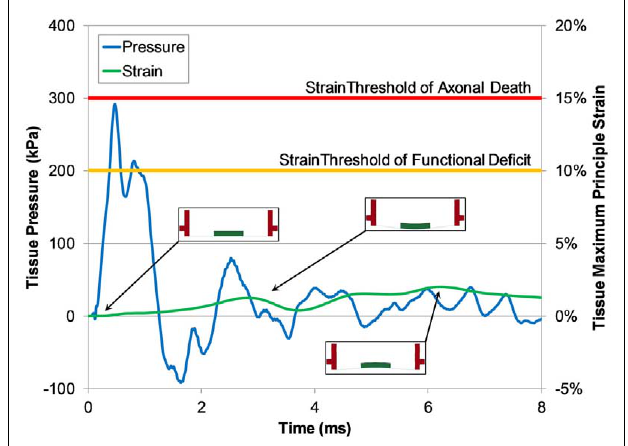
FIGURE 11 |A comparison between typical the pressure time-histories of the FE shock tube and receiver model and the experimental pressure traces at the same blast condition (3700kPa burst). Pressure contours show the time-lapsed progression of the pressure pulse traveling down the test column and dispersing into the reservoir (inset).